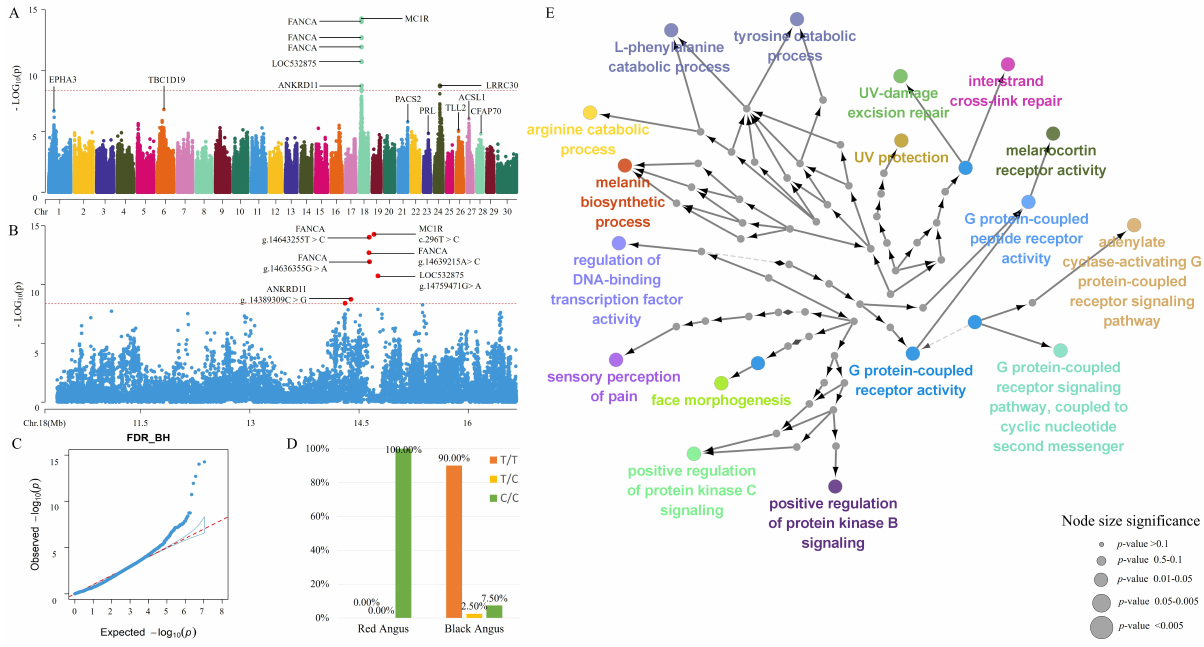
Figure 1. GWAS of autosomal SNPs in Angus cattle by using PLINK. ( A ) Manhattan plot of autoso- mal SNPs; ( B ) Manhattan plot of partial chromosome 18 SNPs (CHIR 18_10350193 to CHIR 18_16664071); ( C ) Q–Q plot of autosomal SNPs; ( D ) genotype frequencies of MC1R SNPs (c.296T> C); and ( E ) GO term enrichment of ANKRD11 , FANCA , and MC1R as an interaction network con- structed using the Cytoscape plug in ClueGO.